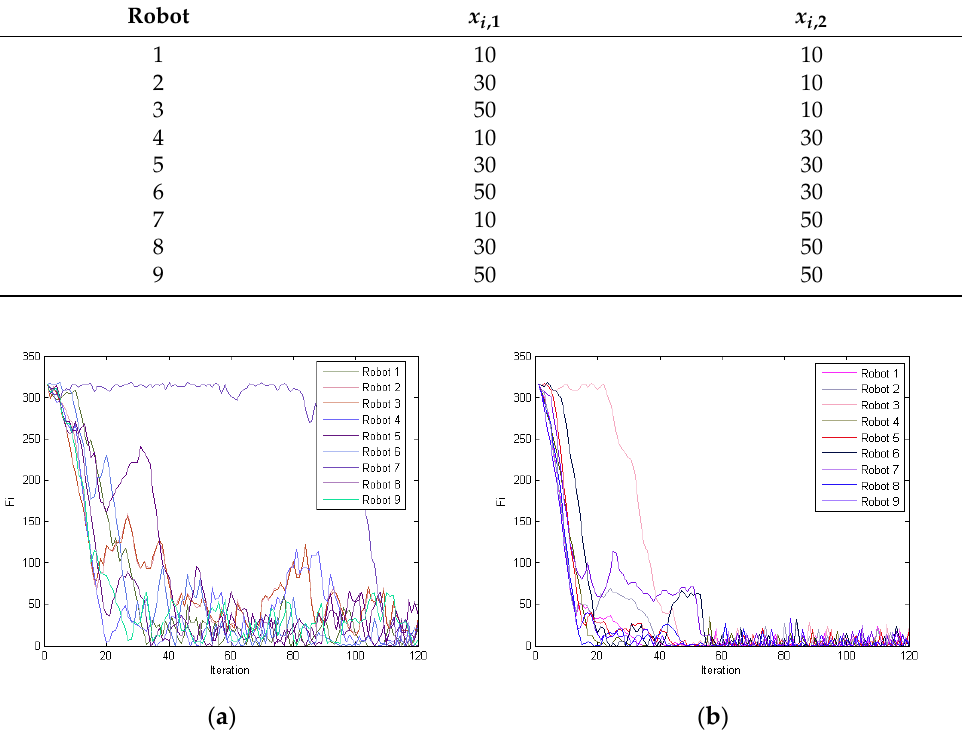
Figure 17. The S evolution of two methods without and with noise for aggregation . The red and purple lines are for the controller without and with noise in Reference [27], respectively. The blue and green lines are for BCCS without and with noise, respectively. Table 5 shows the simulation results of two methods for aggregation in a noise free environment. It is worth mentioning that the initial positions of robots for the two meth- ods are randomly generated in local space and the same. Although all simulation results